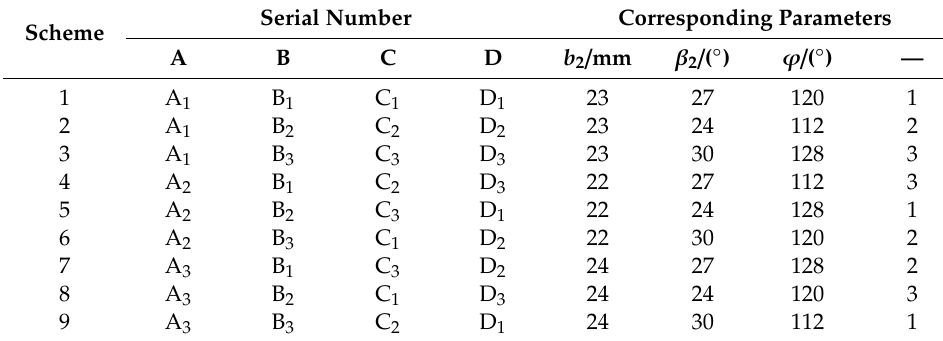
Table 8. The orthogonal table